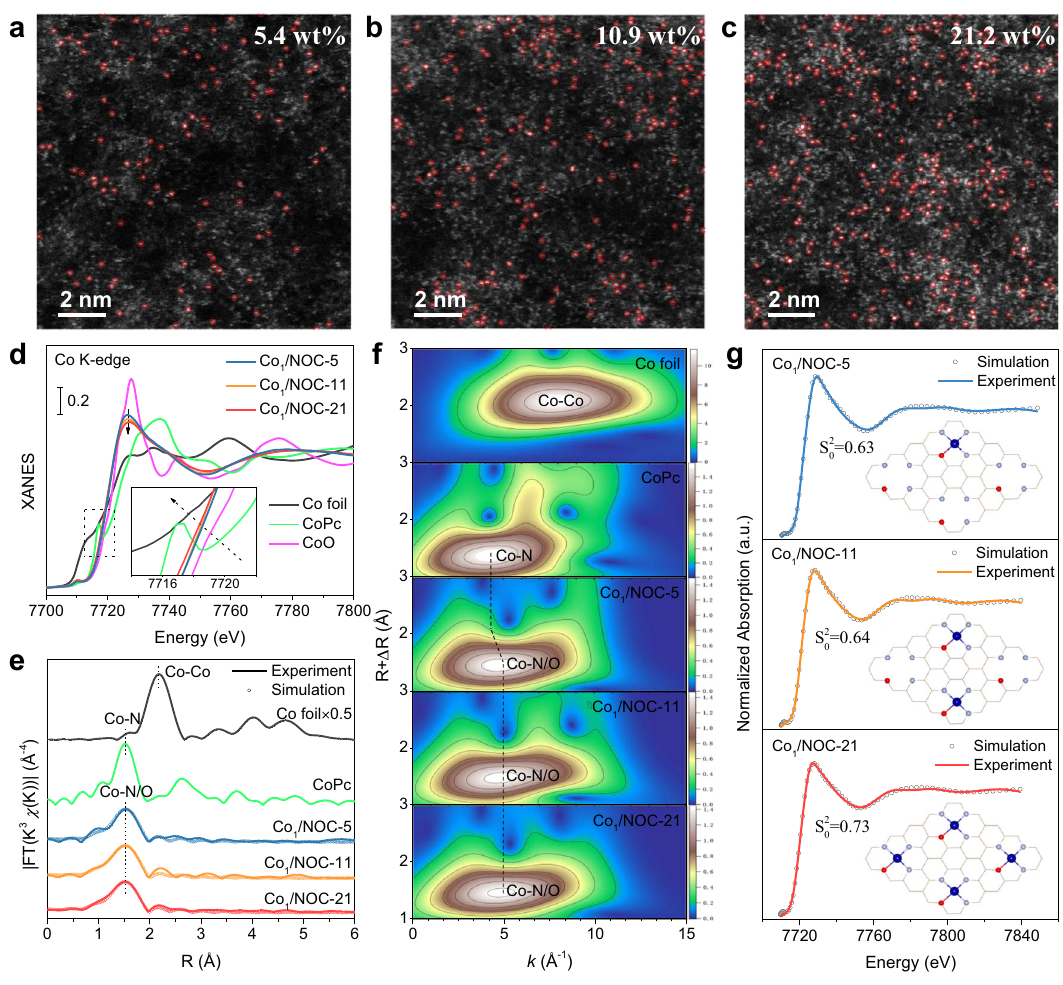
Fig. 2 | Characterizations and atomic structural analysis of Co SACs with dif- ferent density. a – c AC HAADF-STEM images of 5.4wt%, 10.9wt%, and 21.2wt% Co SAC samples. Co single atoms are marked in red circles. d Normalized Co K-edge XANES spectra. e k 3 -weighted Fourier transform spectra of Co 1 /NOC-x and